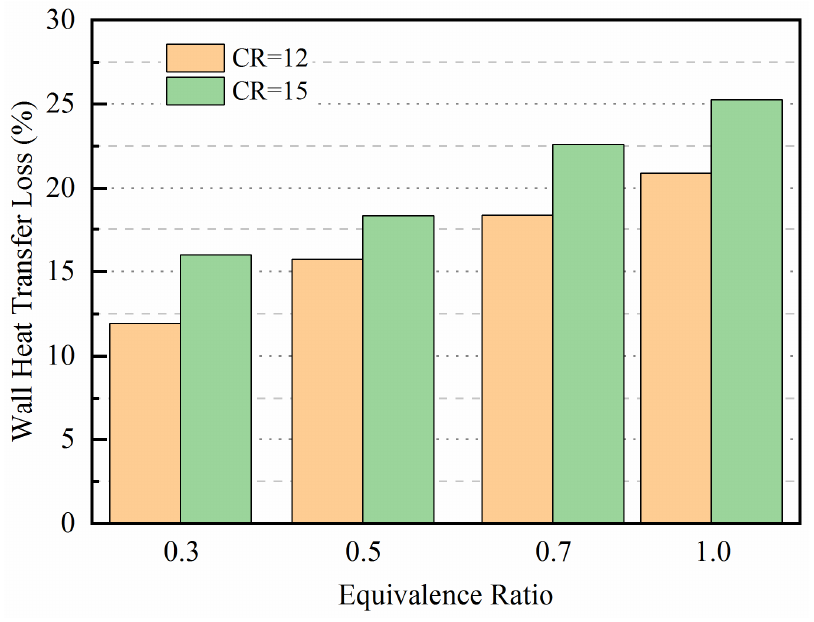
Figure 6. The proportion of wall heat transfer loss at different equivalence ratios [48].